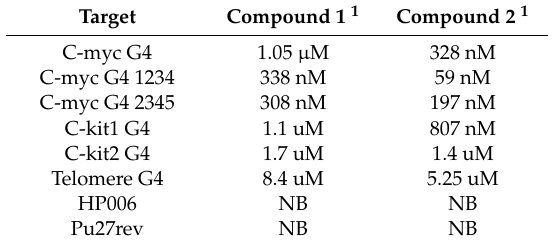
Table 2. K D values for reported compounds as determined by Surface Plasmon